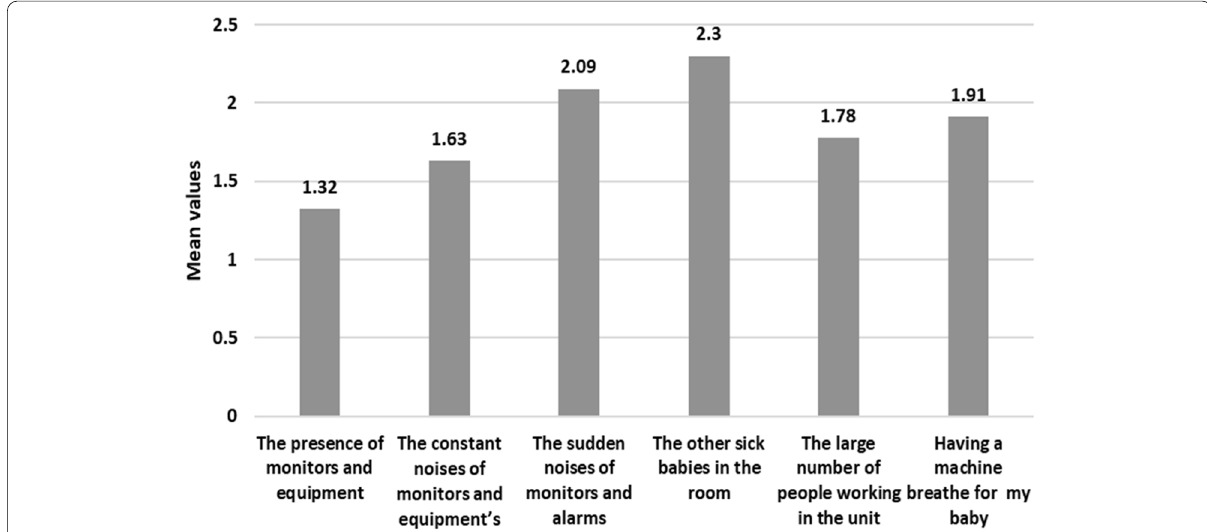
Fig. 1 Mean Stress Scores of each component of Sight and Sound domain (domain 1) of PSS: NICU scale